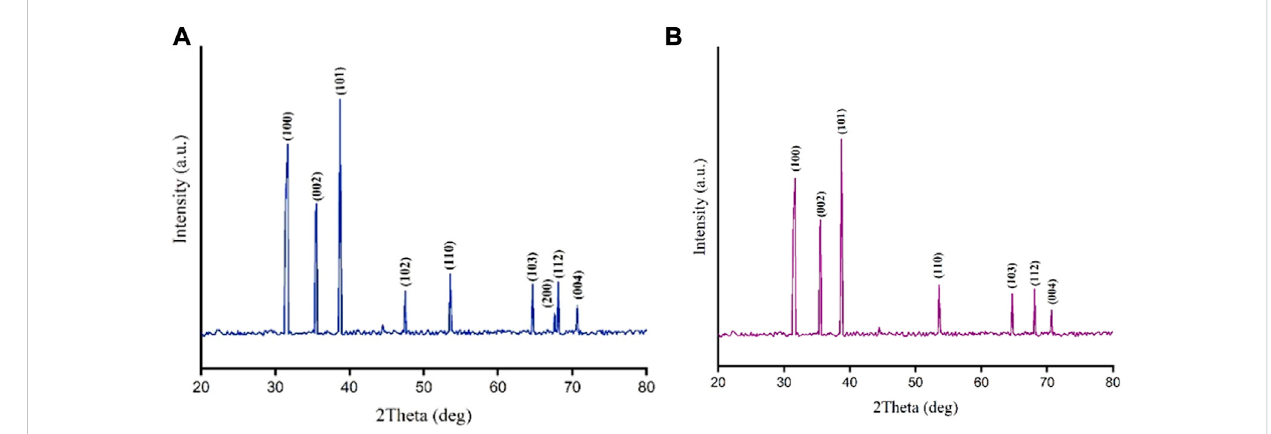
and 500 μ g/ml for E. coli . Likewise, the MBC values of calcined CuONPs were determined as 250 μ g/ml for B. subtilis and S. aureus , and 500 μ g/ml for P. putida and E. coli .